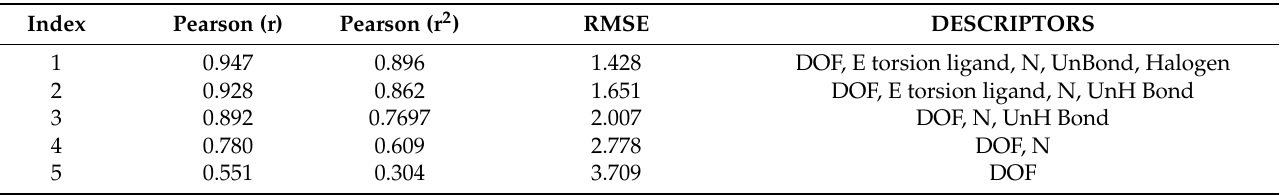
Table 3. Descriptors used in QSAR model for E. coli .